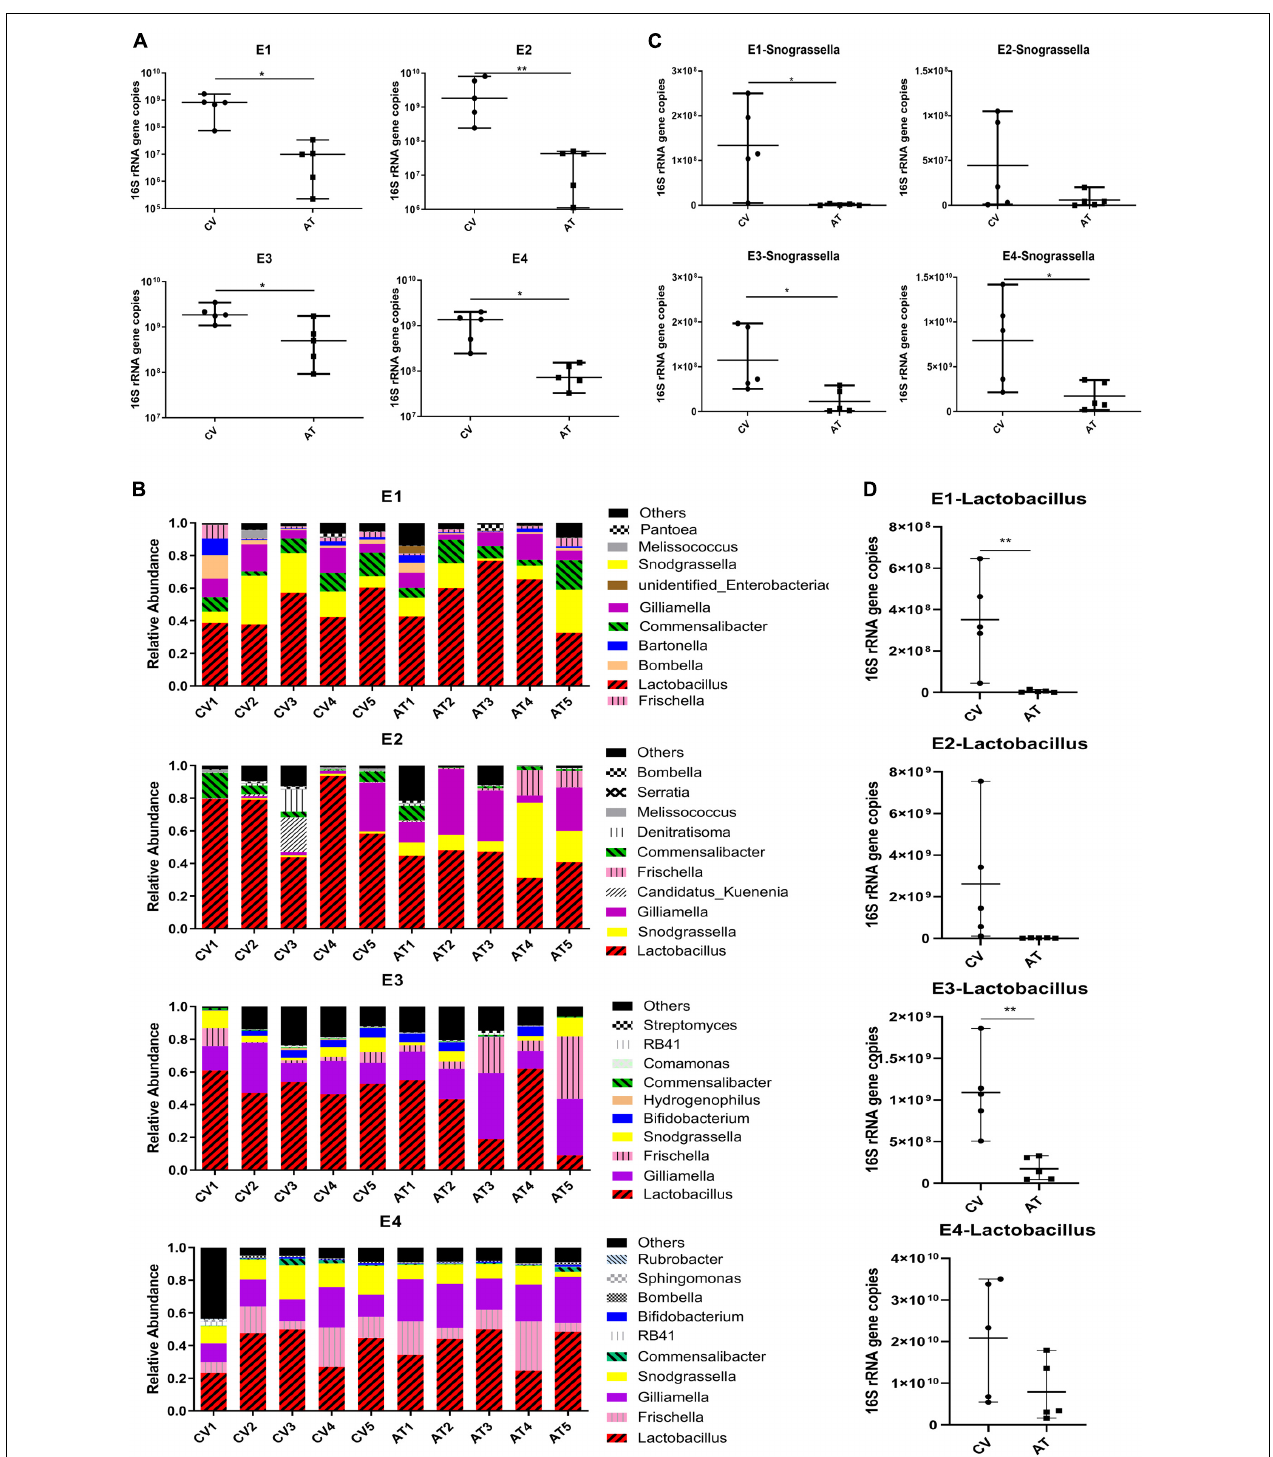
FIGURE 1 | Changes of honey bee gut microbiota after tetracycline treatment. (A) The absolute abundance of gut bacteria of CV and AT workers ( n = 5), total bacterial 16S rRNA gene copies were estimated by qPCR. (B) Stacked column graph showing the relative abundance of bacterial species in CV and AT workers. (C) The absolute abundance of Snodgrassella in CV and AT workers ( n = 5). (D) The absolute abundance of Lactobacillus in CV and AT workers ( n = 5). * p < 0.05, ** p < 0.01, student’s t -test. CV, conventional gut community workers, AT, Antibiotic treated